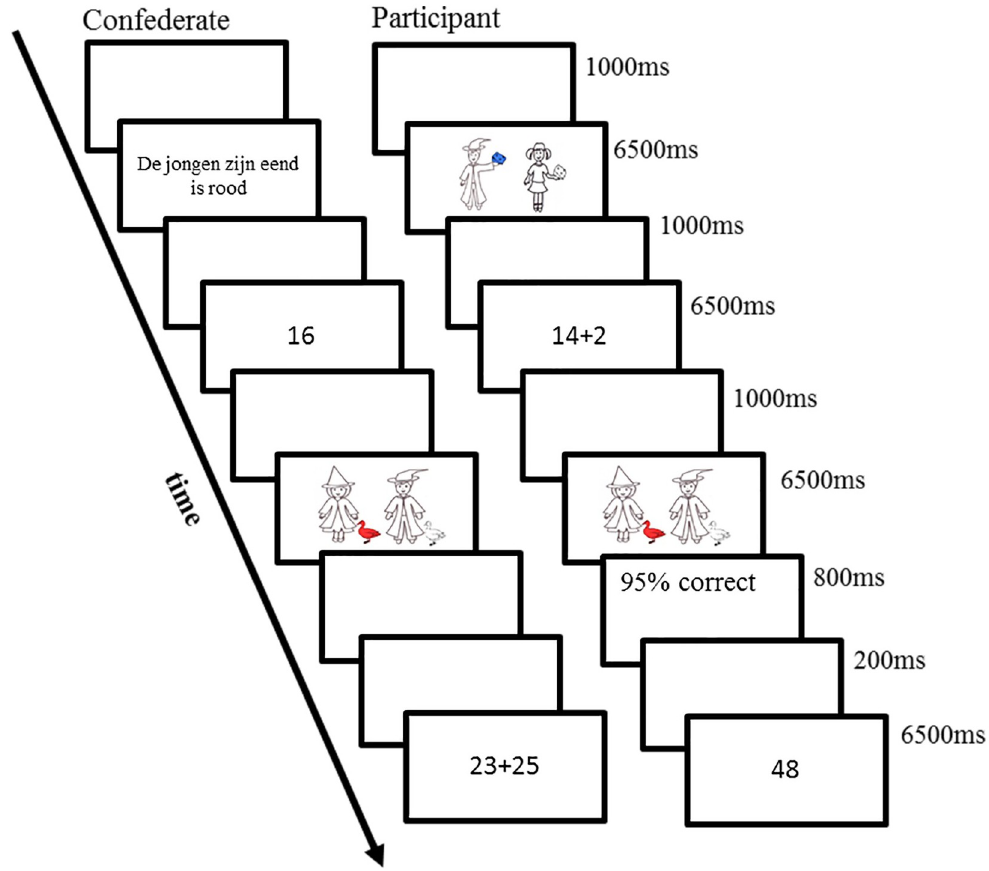
Fig 2. The procedure in Experiment 1a. Each trial for participants consisted of the following events: After a 1000 ms interval the prime sentence was presented auditorily (by the confederate) and simultaneously a verification picture